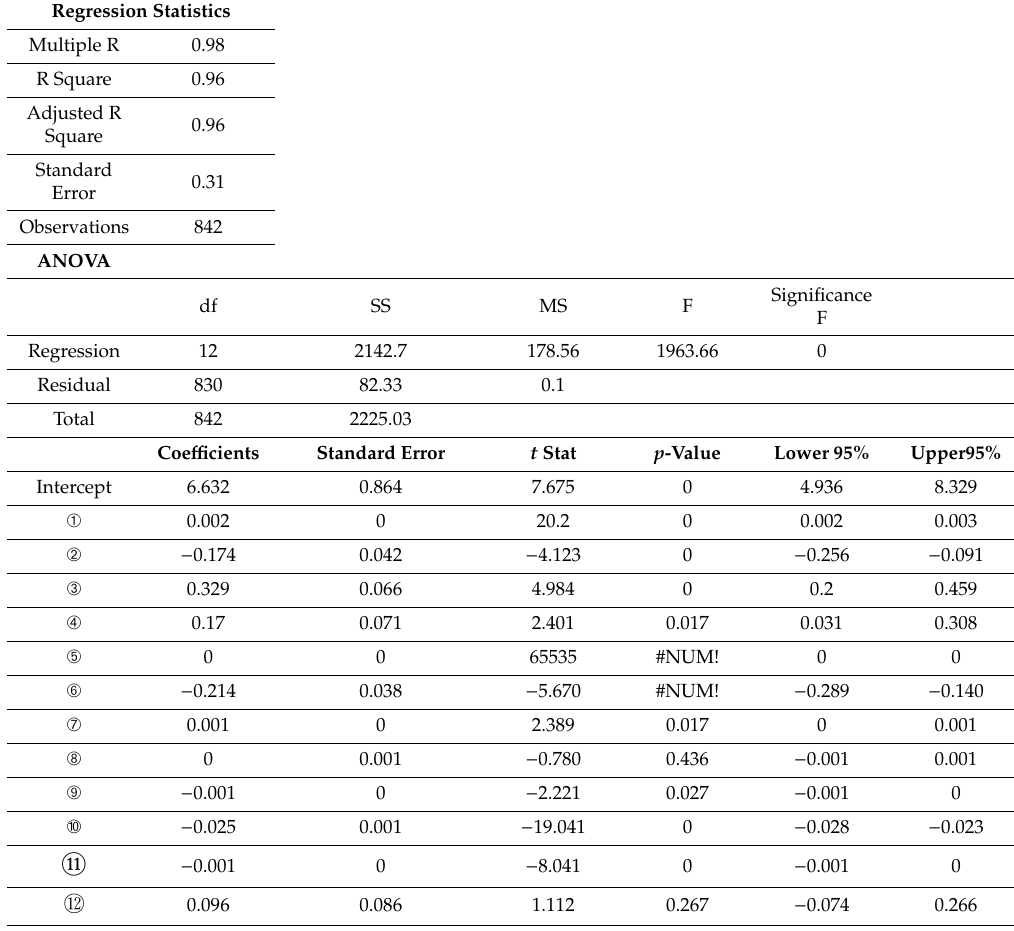
Table 4. Correlation between heating load of air-based solar heating system and climatic factors (12 items).